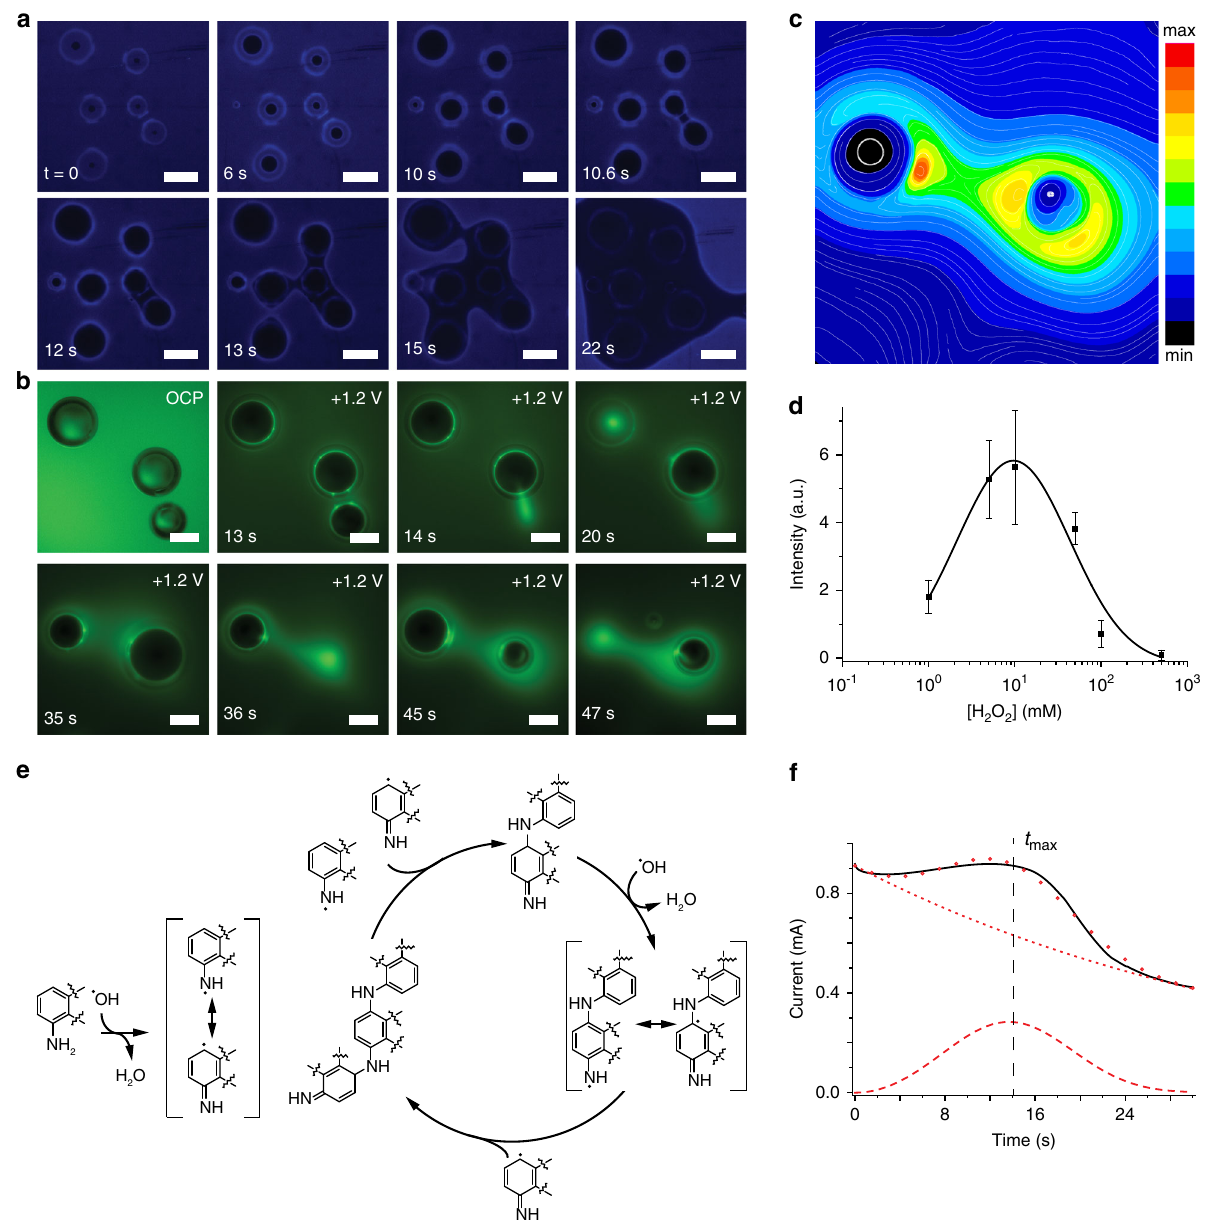
Fig. 3 Step polymerization initiated at the corona of surface bubbles. a Selected chemiluminescence microscopy (10×, em 440nm) timeframes (Supplementary Video 5) of the anisotropic polymerization reaction initiated at the gas – liquid interface of oxygen bubbles adhered on an ITO anode ( + 1.2V vs. SHE) in an aqueous solution of sodium hydroxide (0.1M), luminol (0.05 M), and hydrogen peroxide (0.3% v/v). Scale bars are 200 µ m. b Selected epi fl uorescence microscopy timeframes (Supplementary Video 7) for the detection of reactive oxygen species around oxygen bubbles adhering on an ITO electrode (OCP and + 1.2V vs. SHE) in a solution containing DCFH 2 -DA (100 µ M), sodium hydroxide (0.1M), and hydrogen peroxide (0.3% v/v). Scale bars are 200 µ m. c Contour line color map representing the O 2 • − gradient around bubbles, as from the epi fl uorescence image in ( b ) ( t = 45s). d Competition of luminol and HO 2 − for HO • revealed by measurements of electrochemiluminescence intensity as a function of the hydrogen peroxide concentration (platinum gauze as working electrode, + 1.2V vs. SHE, 5.0 ×10 − 2 M luminol, 0.1M sodium hydroxide). Mean values with a 90% con fi dence limit were calculated based on three independent measurements. The mean values were fi tted with a Gaussian function (solid line). e Polymerization mechanism. f Amperometric curve recorded during the experiment in ( a ), solid line. Symbols are simulated curves, including contributions from a diffusion-limited instantaneous growth (long dashes) and from an electron transfer of an adsorbed electroactive species (short dashes). Details on fi tting parameters and the model are in Supplementary Note unbalanced excess of hydroxide anions. In the proximity of the bubbles can affect anisotropic oxidative redox chemistry. The electrode surface, unbalanced anions are oxidized to highly results presented here are likely to be a general mechanism to reactive hydroxyl radicals at potentials as low as + 1.2 V vs. SHE. initiate, enhance, or localize oxidative processes occurring in The gradient of reactive oxygen species surrounding adherent water electrolytes.